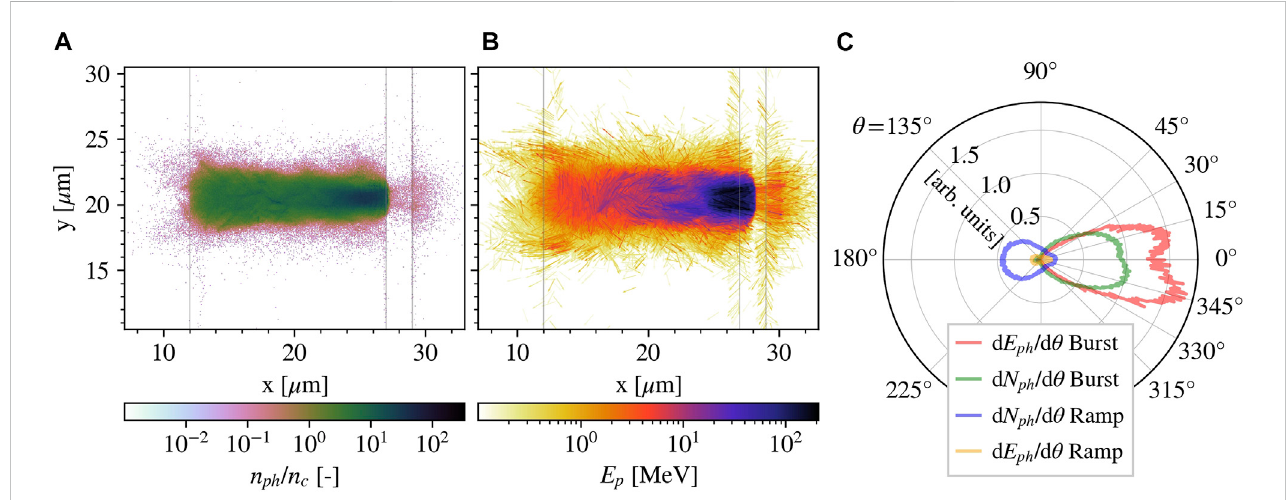
FIGURE 2 Spatial and angular information on photon emission: the distribution in space of photon number density normalized to n c (A) , the emitted photons representedasarrowsdirectedaccordingtotheirmomentumandcoloredaccordingtotheirenergy E p (B) ,andthephotonangulardistributioninnumberand energy (C) for thetwo phases of emission, that is, ramp(before 110 fs)and burst (after 110fs). The three plots consider all the photons emitted insimulation A. In plots (A) and (B) , photons are fi xed in their emission position and grey lines indicate the target limits at the beginning of the simulation. The angle θ of the distribution in (C) is zero in the laser propagation